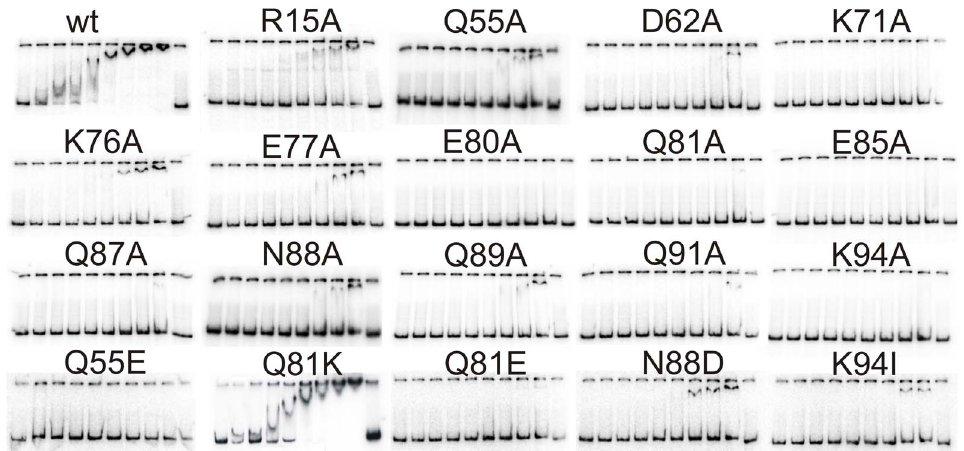
Figure 2. Gel shift assays of various AbrB-mutants bound to the phyC -region. The AbrB-protein concentrations (from left to right) for each gel were 0 m M, 0.5 m M, 0.75 m M, 1 m M, 1.5 m M, 2 m M, 3 m M 4 m M, 6 m M, and 0 m M. The substitutions are specified above each gel, wt indicates the native AbrB-protein of B. subtilis 168 and AbrB BA corresponds to the protein of B. amyloliquefaciens FZB45.